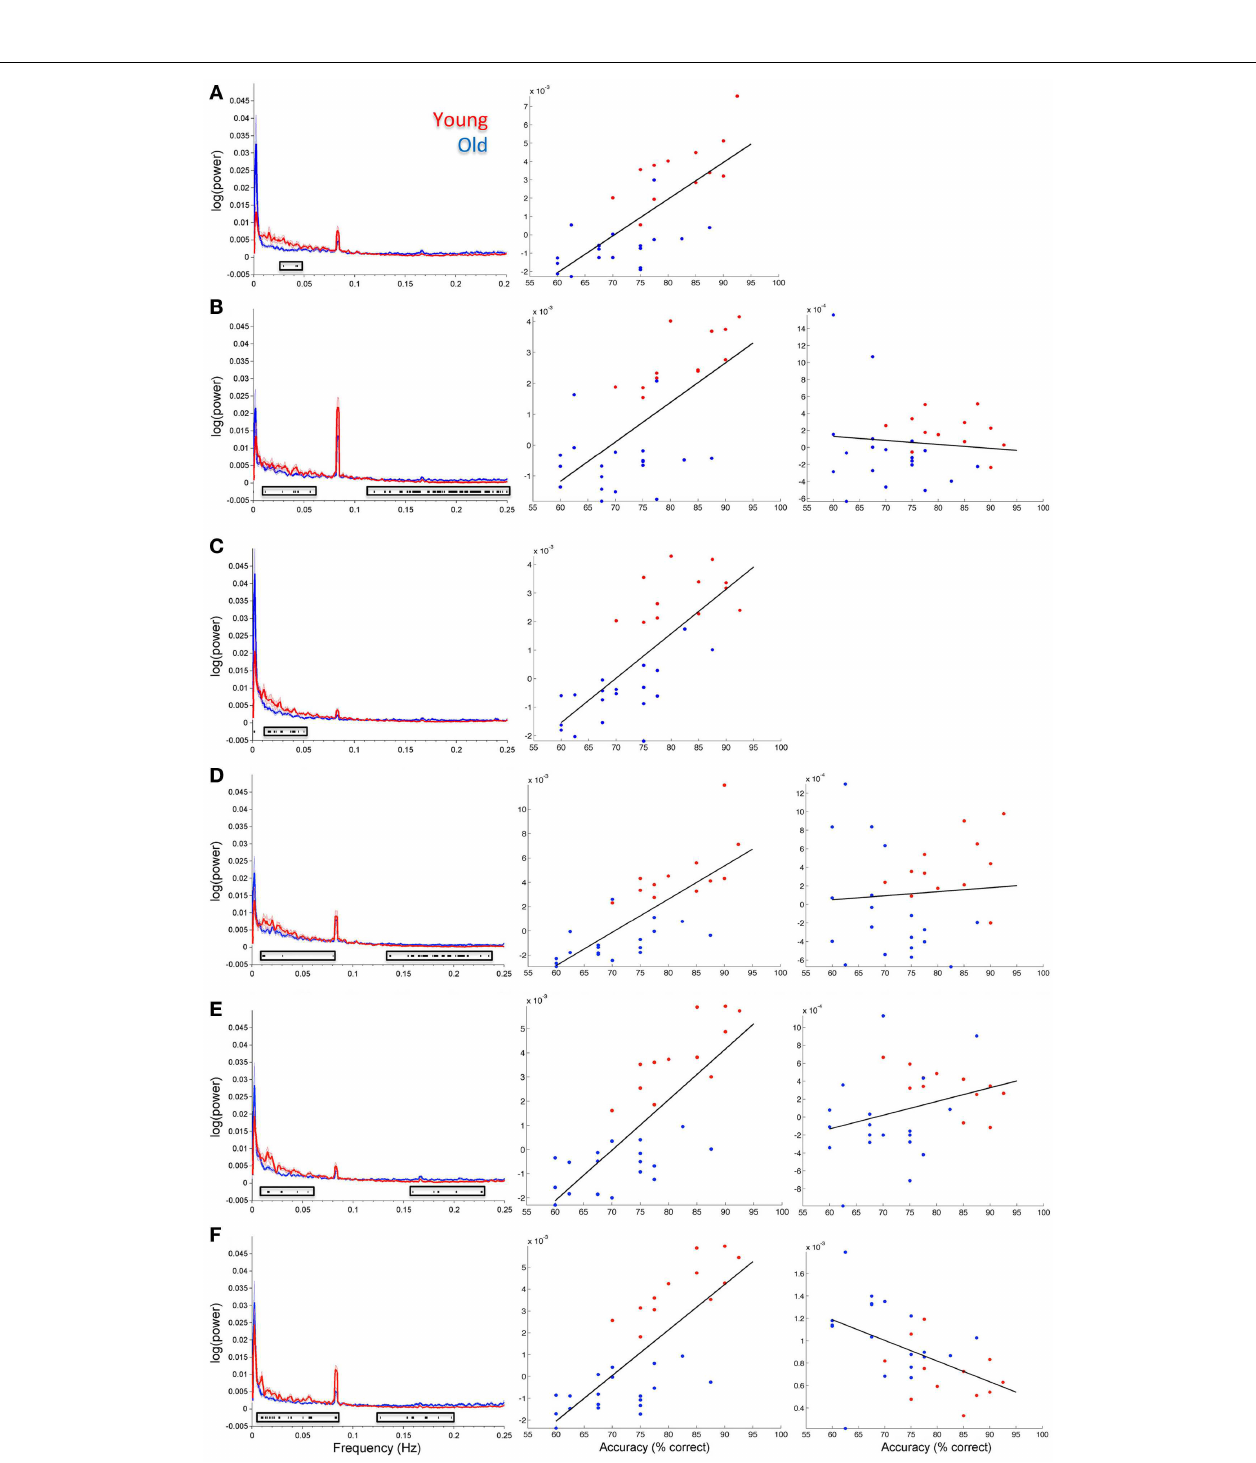
FIGURE 5 | Group spectral profiles and correlations with face match accuracy . Left column shows spectral power distributions for young and old participants. Shaded error bars show the standard error. Black markers underneath highlight where spectral power covaried with task accuracy (these are the same values shown in Figure 4). Middle and right columns show correlations with spectral power and accuracy after age was regressed